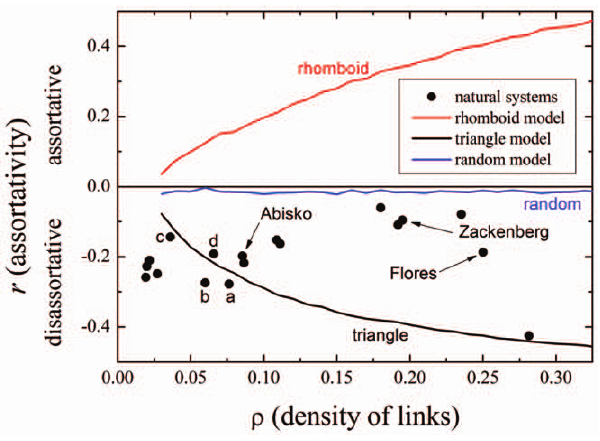
Figure 3. Assortativity as a function of density of links. The lines show the behavior of three models ( 50 | 100 triangle, rhomboid and random, averaged of 100 realizations), while the points correspond to the real networks reported in [22]. The upper half of the plot correspond to assortative networks, while the lower half contains the disassortative ones (including all the natural systems). The density of links r represents the number of links present in the system divided the total possible links ( N | M ). The networks represented in Fig. 2 are marked, as well as four other networks used below.